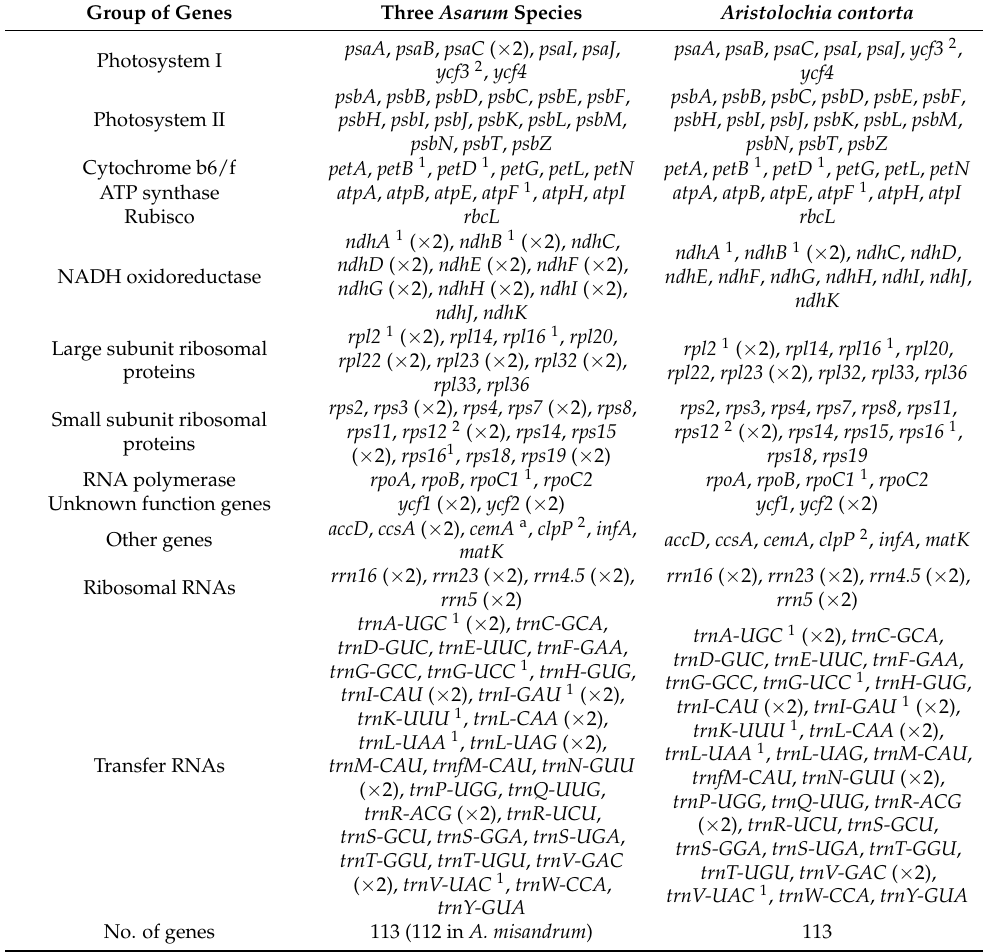
Table 2. List of genes within plastomes of three Asarum species and Aristolochia contorta in Korea. Group of Genes Three Asarum